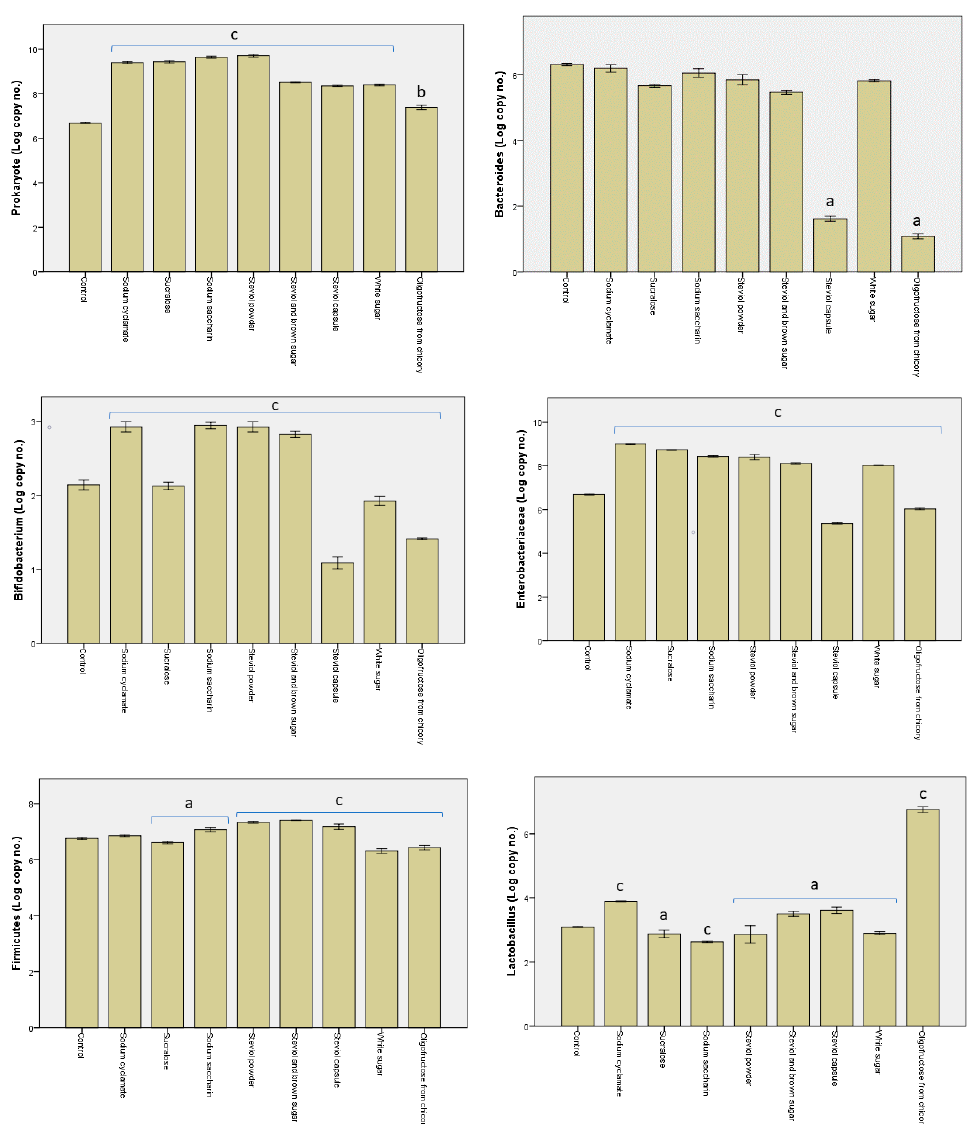
Figure 3. Log of the number of copies obtained post the in vitro tests through the GS1 system as a measure of the impact of the sweeteners on the pattern of the microbiota. Different letters indicate significant statistical differences (a: p ≤ 0.05; b: p ≤ 0.01; c: p ≤ 0.001), n = 3.